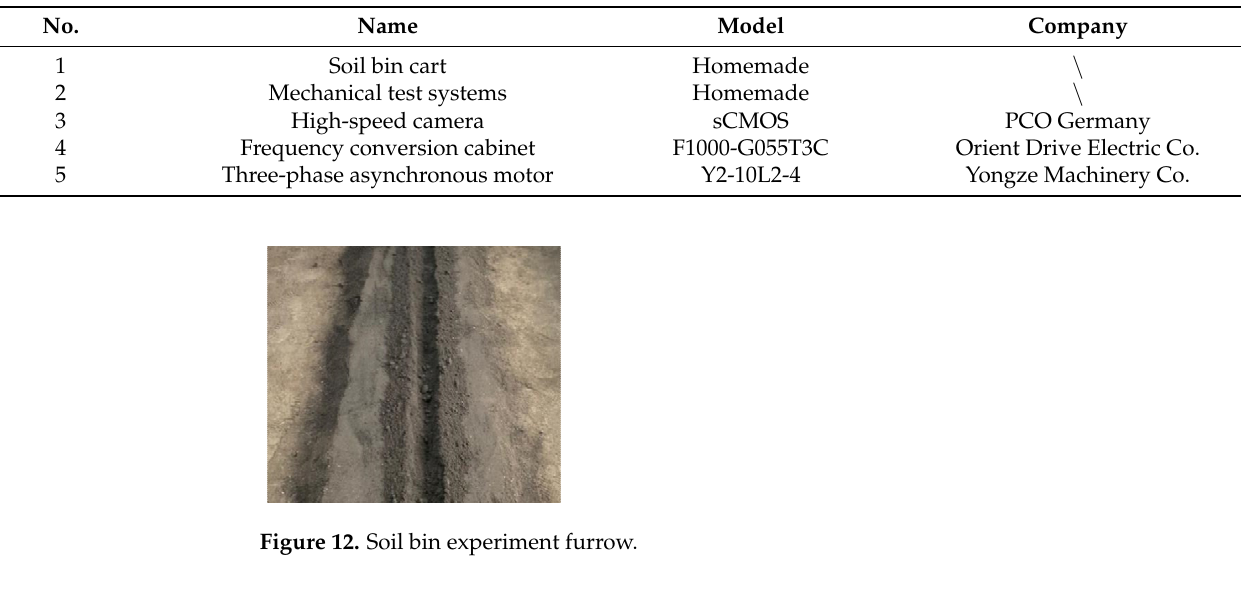
Figure 13. Quantitative method of furrow . Table 7. Equipment model and parameters. No.